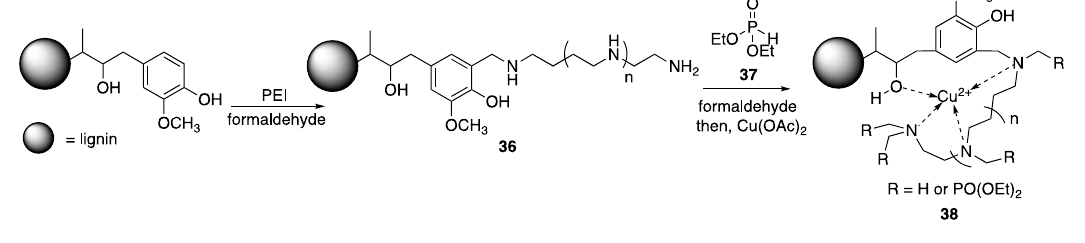
Figure 19. Synthesis of metalated lignin, 38 .